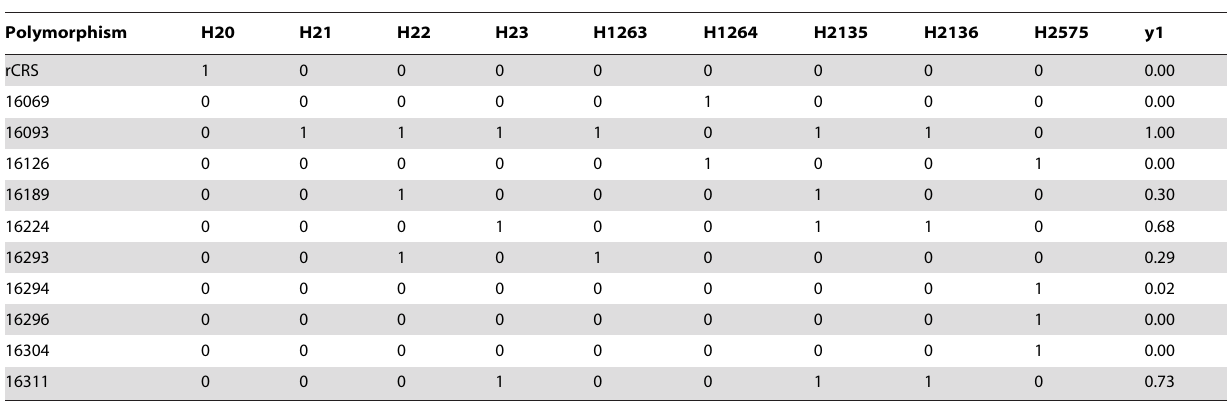
Table 2. Table 1 with quantitative information.